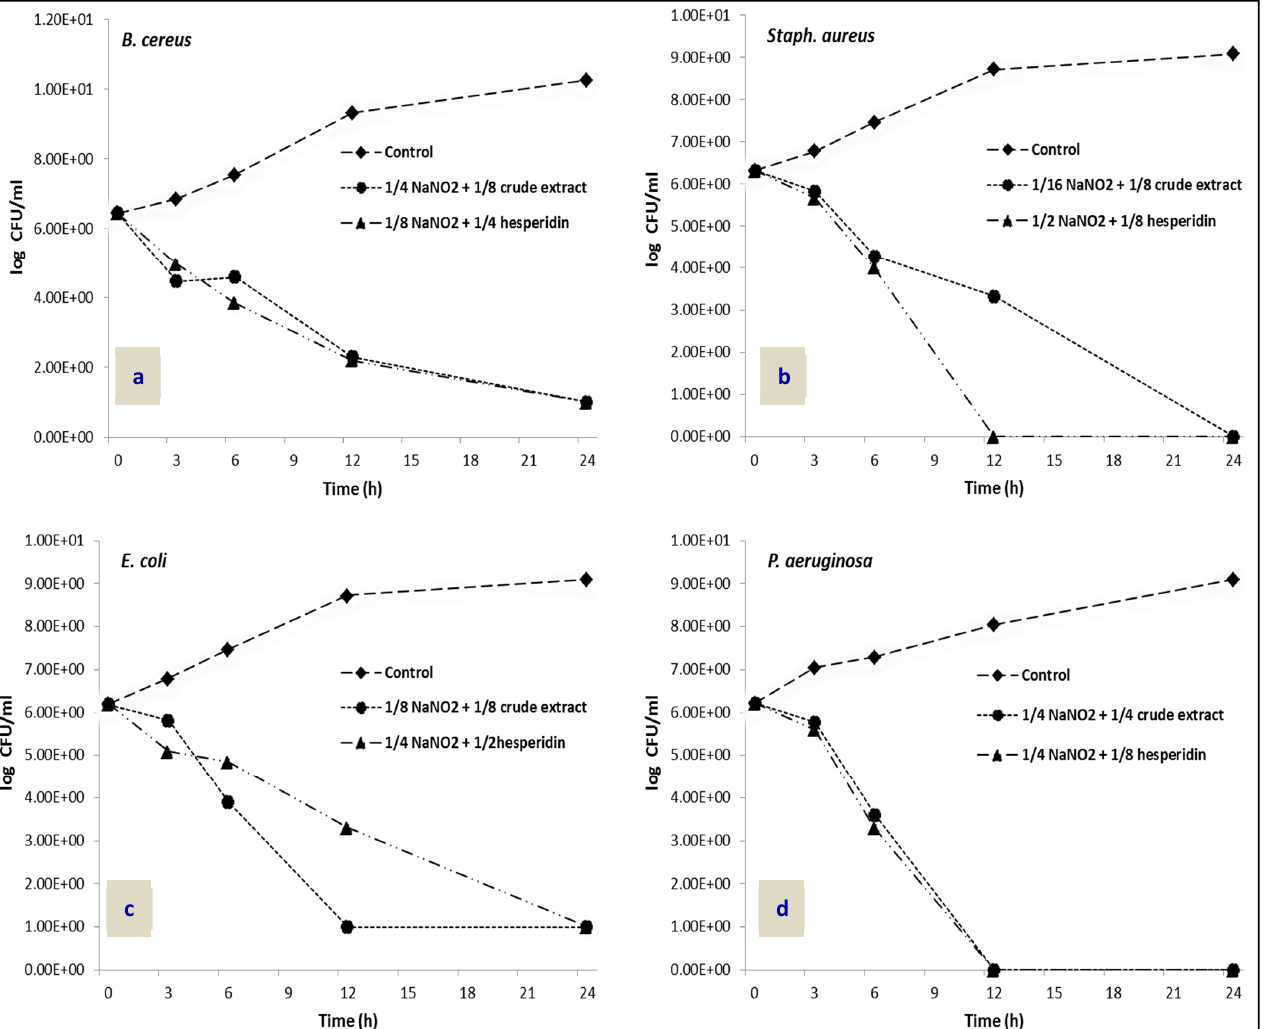
Figure 4. Time–kill data for synergistic combination of NaNO 2 with mandarin peel extract and hesperidin against ( a ): B. cereus ; ( b ): Staph. aureus ; ( c ): E. coli ; ( d ): P. aeruginosa.